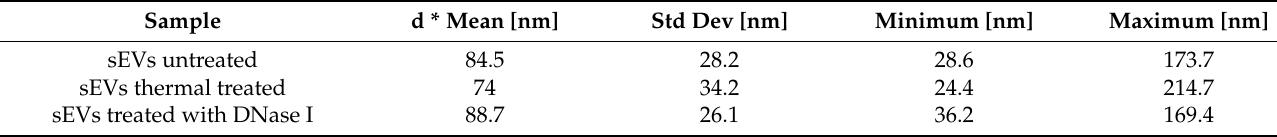
Table 4. Size distribution of